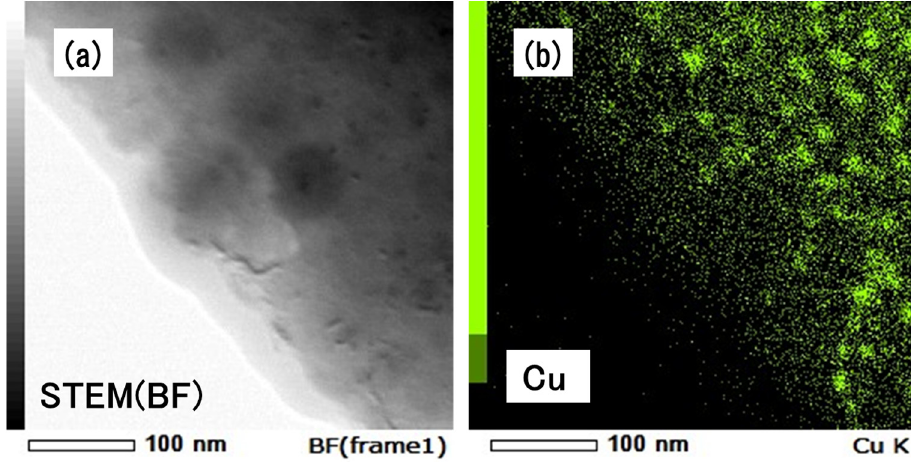
Figure 6. STEM bright-field image ( a ) and corresponding Cu atom map ( b ) for Fe-0.6wt%Cu alloy.